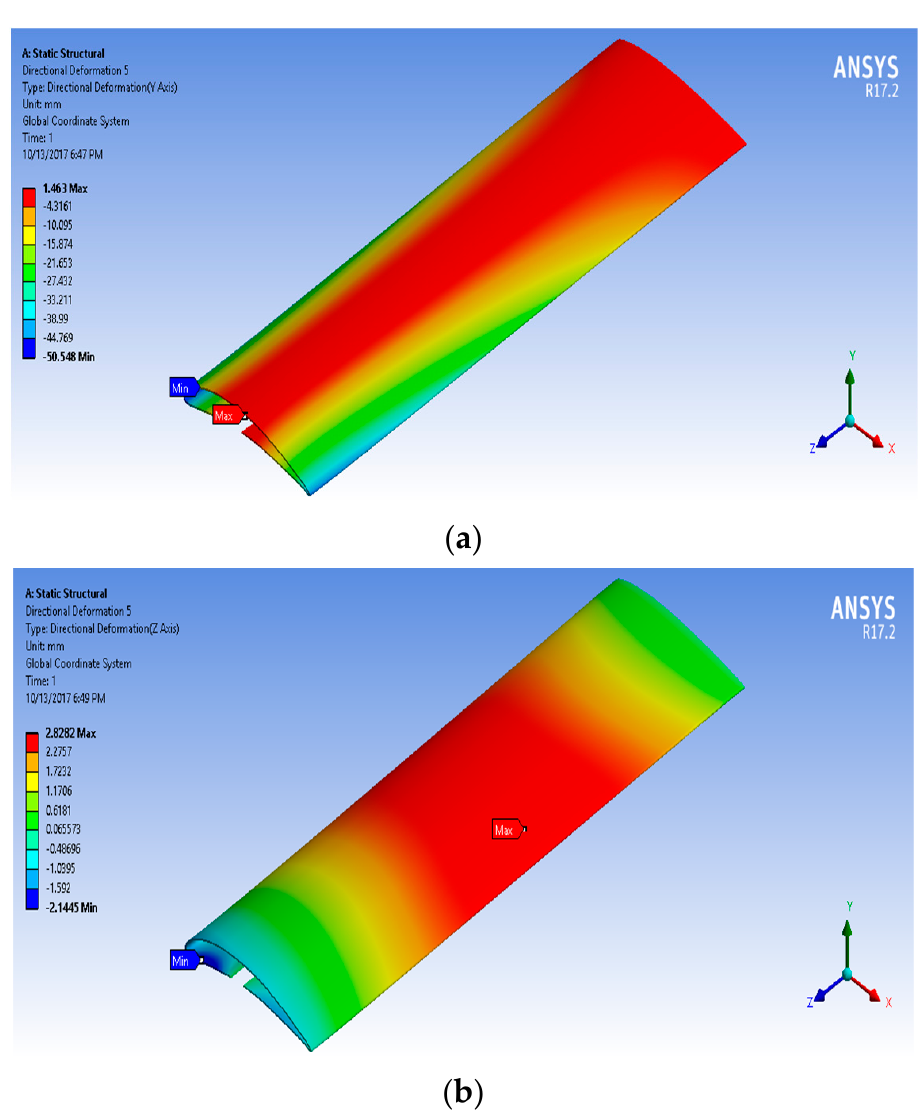
Figure 18. Sectional output (maximum shear stress) distribution to morph NACA2410 to NACA8410 along the wing.